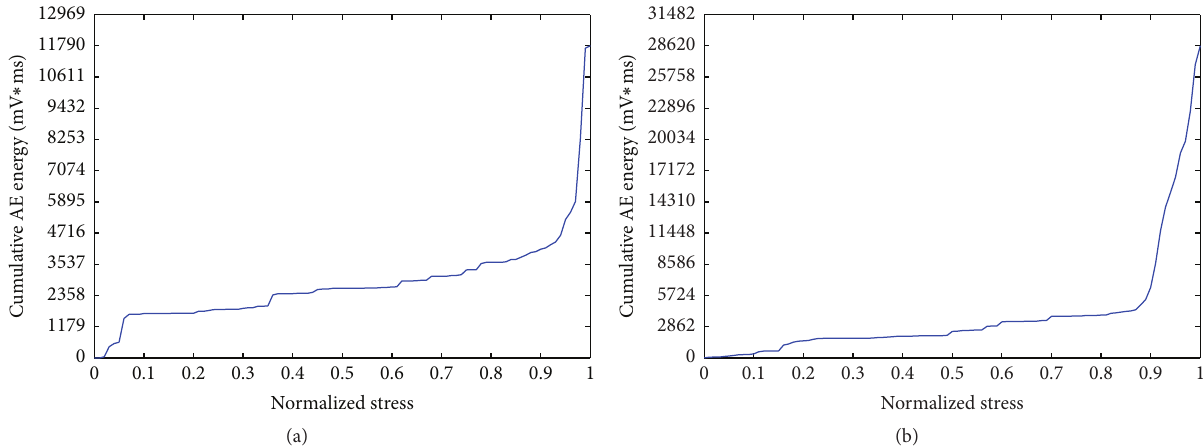
Figure 7: Variation of cumulative AE energy with relative stress: (a) sensor fixed on the end of specimen and (b) sensor fixed in the middle of